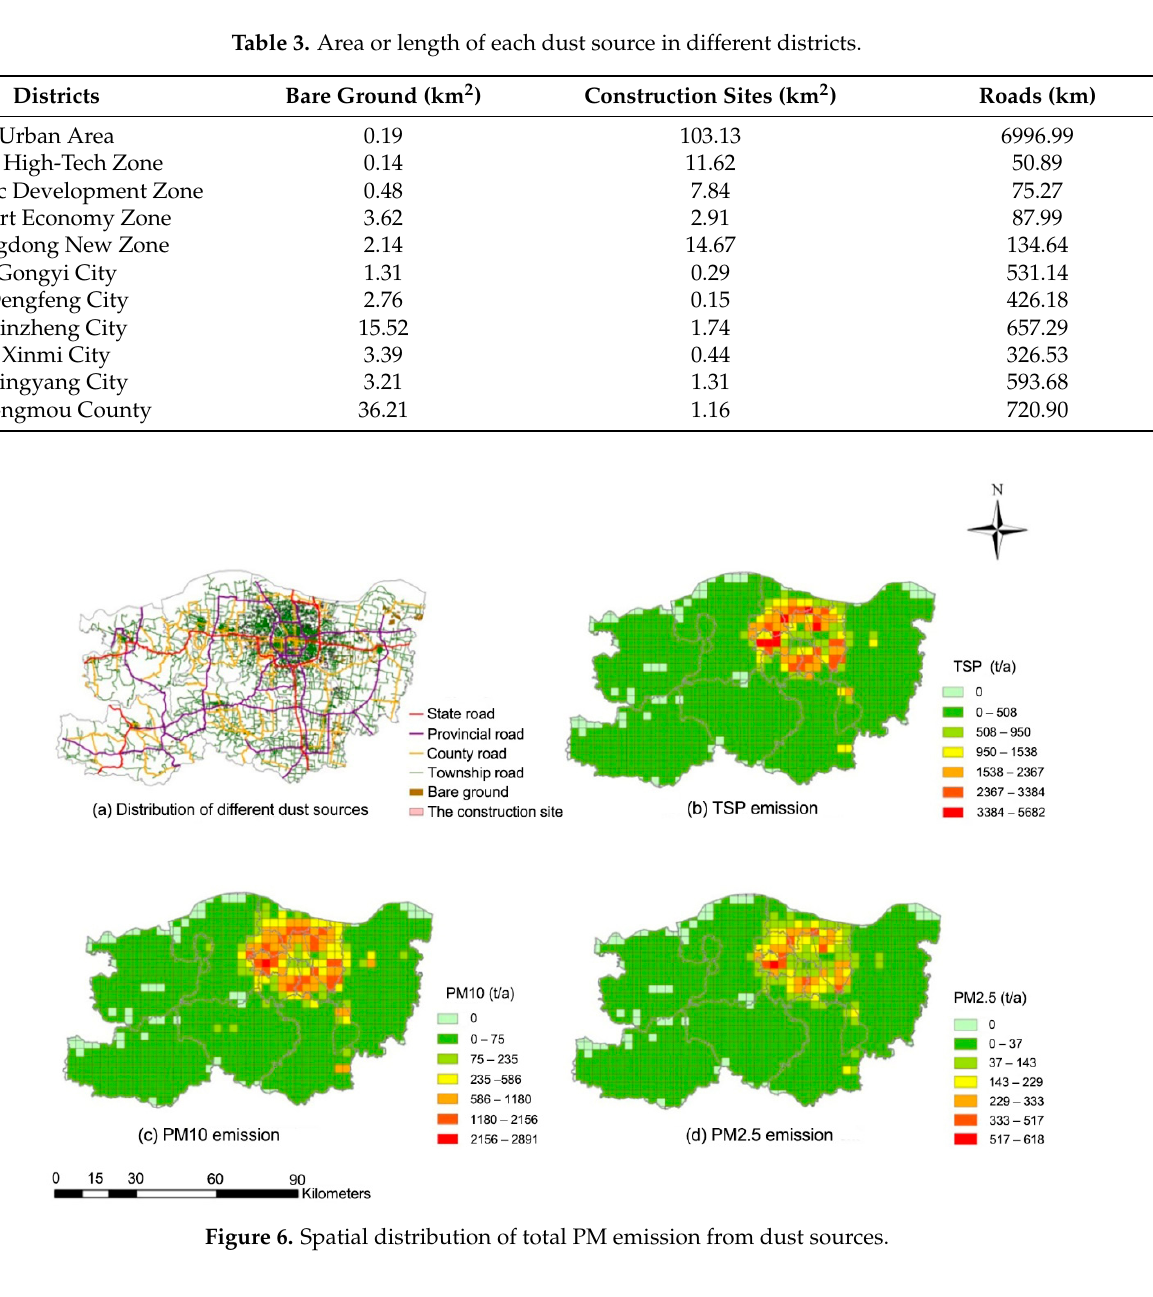
Figure 6. Spatial distribution of total PM emission from dust sources